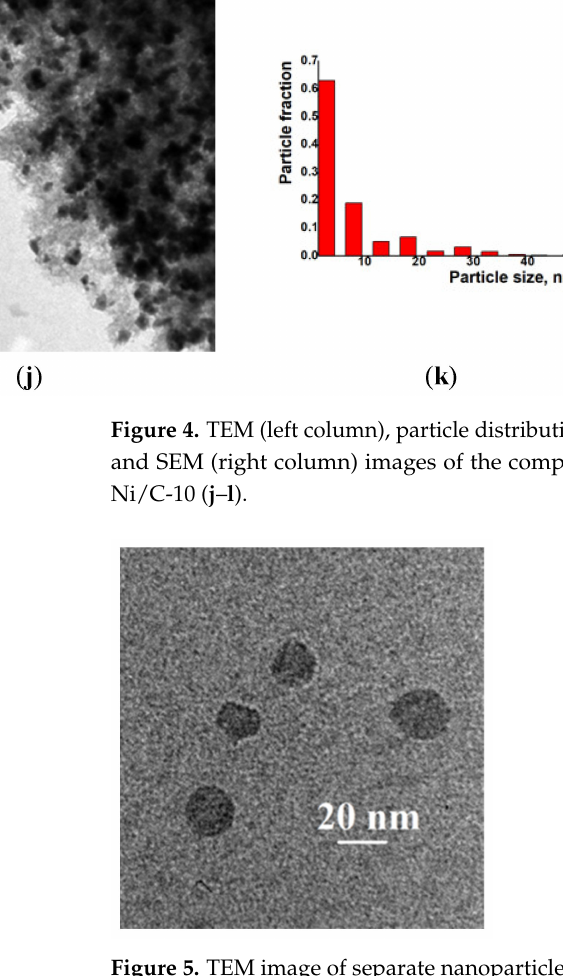
Figure 5. TEM image of separate nanoparticles in the Ni/C-1